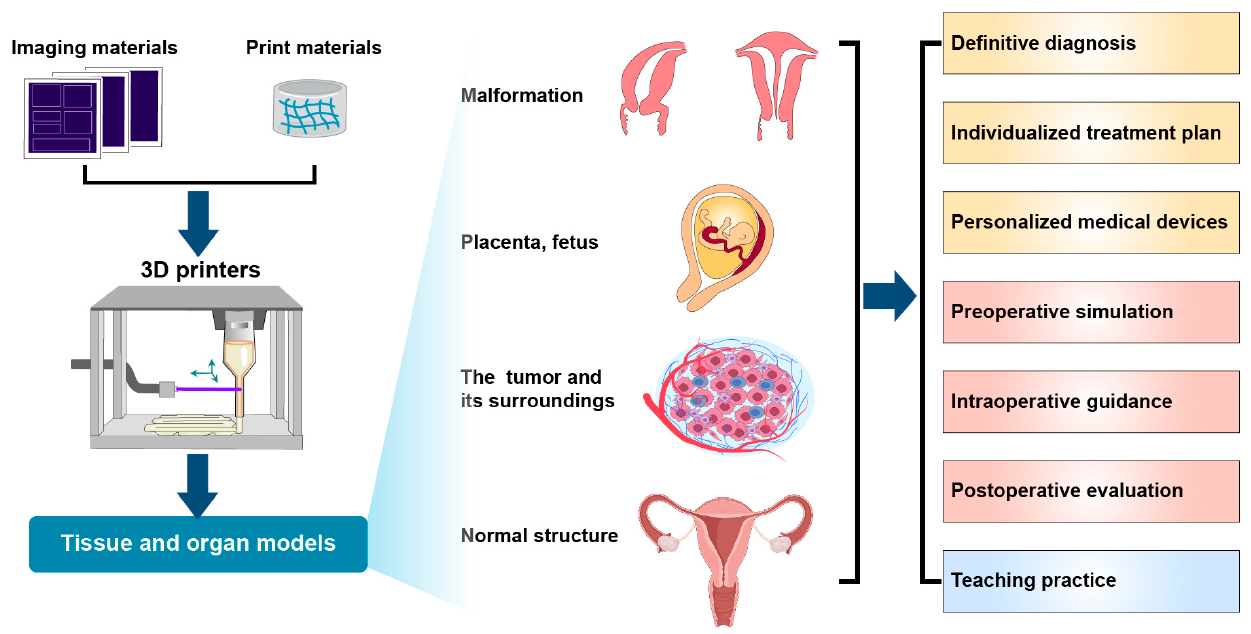
Figure 3. The process of 3D printing and its applications.